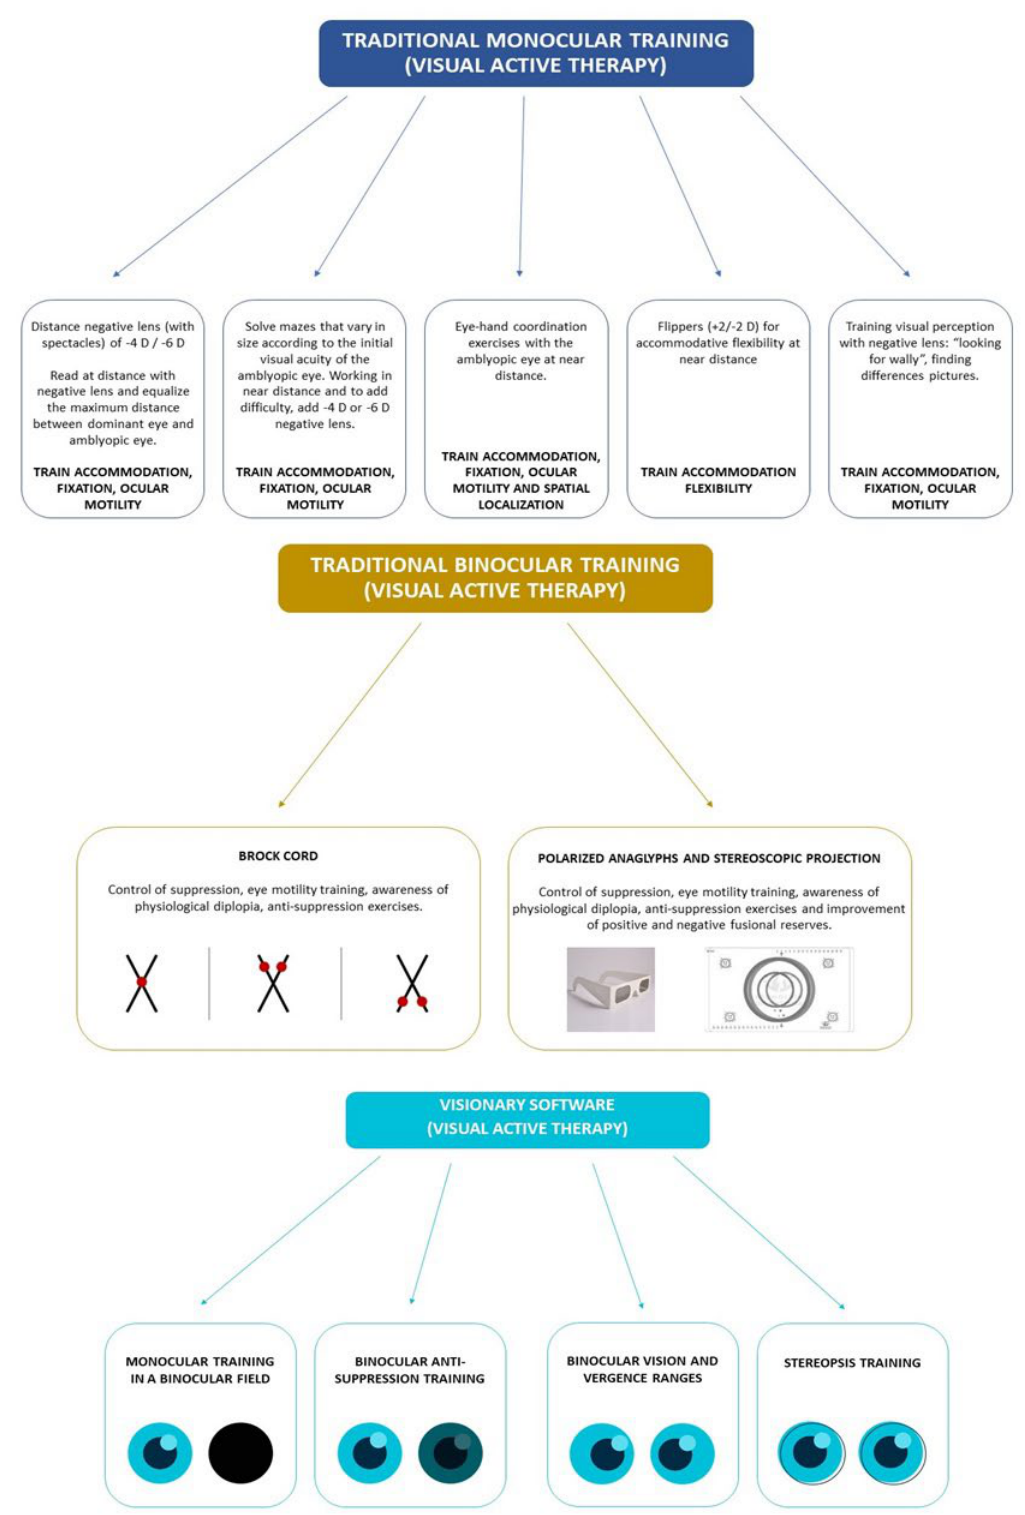
Figure 1. Diagram showing the type of vision therapy performed in the current study.